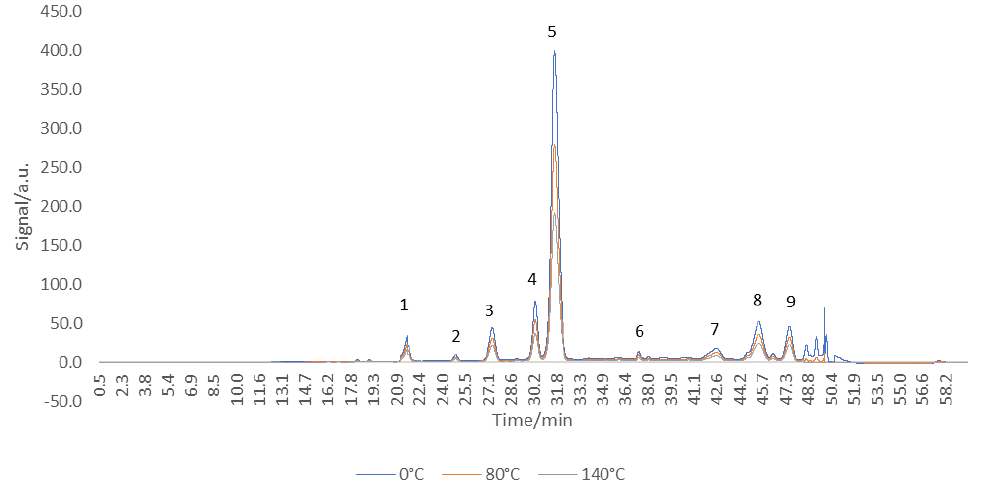
Figure 6. HPLC chromatograms of anthocyanin/anthocyanidin profile of Băbească neagră grape skin at 520 nm after thermal treatment at different temperatures for 20 min (Peak 1 — delphinidin 3- O - glucoside; Peak 2 — cyanidin 3- O -glucoside; Peak 3 — petunidin 3- O -glucoside; Peak 4 — pelargo- nidin 3- O -glucoside; Peak 5 — malvidin 3- O -glucoside; Peak 6 — cyaniding; Peak 7 — peonidin 3- O - coumaryl glucoside; Peak 8 — peonidin; Peak 9 — malvidin).